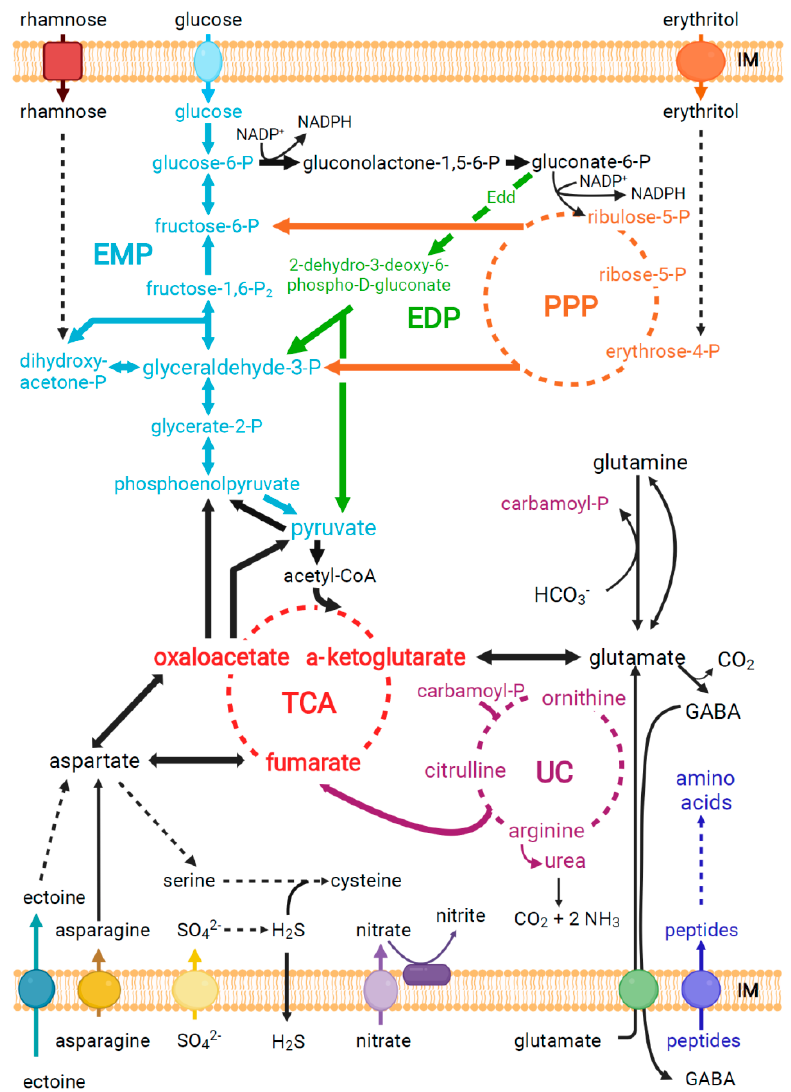
Figure 4. Metabolic pathways of Brucella . Major metabolic pathways of Brucella and examples of substrates fueling this metabolic network, as described in Section 3. The pentose phosphate pathway (PPP), the Embden-Meyer-Parnas (EMP) pathway, the tricarboxylic acid (TCA) cycle, and the urea cycle (UC) are conserved in Brucella . Only a subset of Brucella species harbor an active Entner-Doudoroff pathway (EDP) that correlates with an active phosphogluconate dehydratase (Edd) enzyme converting gluconate-6-phosphate into 2-dehydro-3-deoxy-6-phospho-D-gluconate. Solid lines represent direct substrate conversion by a single enzymatic reaction, whereas dashed lines illustrate multistep conversions of substrates with the involvement of several, subsequent enzymatic reactions. Transporters involved in translocation of indicated substrates from the periplasm across the inner membrane (IM) into the cytoplasm of Brucella are displayed schematically. Acetyl-CoA—acetyl coenzyme A; GABA—gamma-aminobutyric acid; CO 2 —carbon dioxide; HCO 3 − —bicarbonate; H 2 S—hydrogen sulfide; NADP—Nicotinamide adenine dinucleotide phosphate; NH 3 —ammonia; SO 42 − —sulfate. Created with BioRender.com.